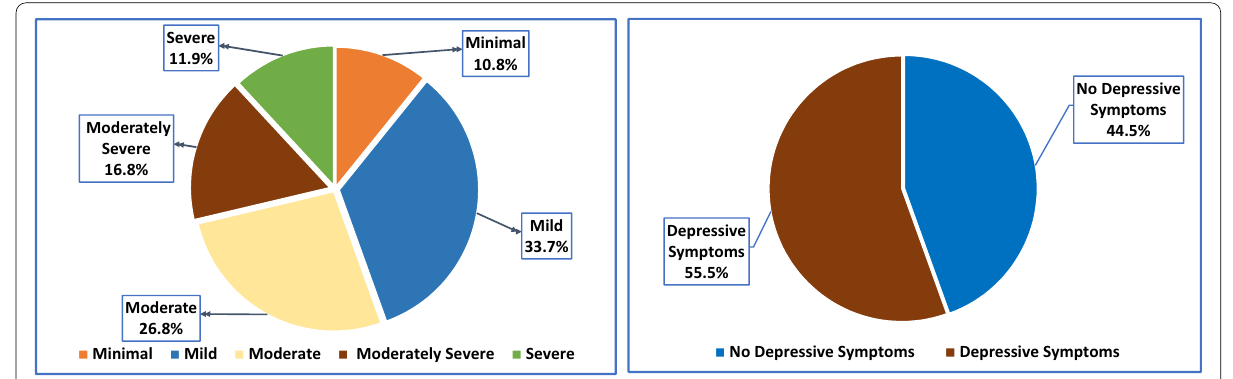
Fig. 1 Distribution of depressive symptoms among studied medical